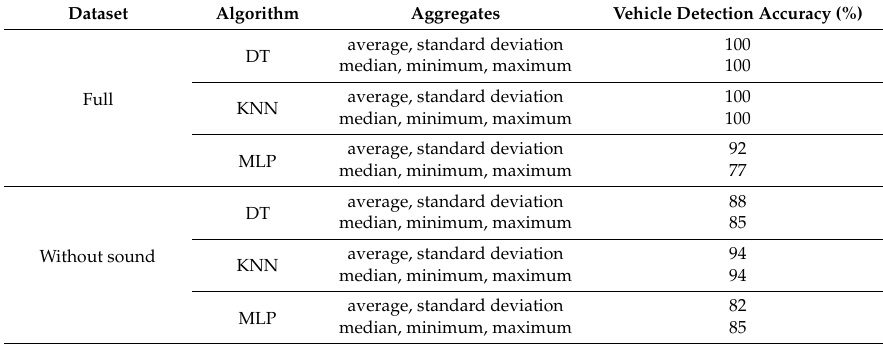
Table 7. Accuracy of vehicle detection based on combined sensor readings from